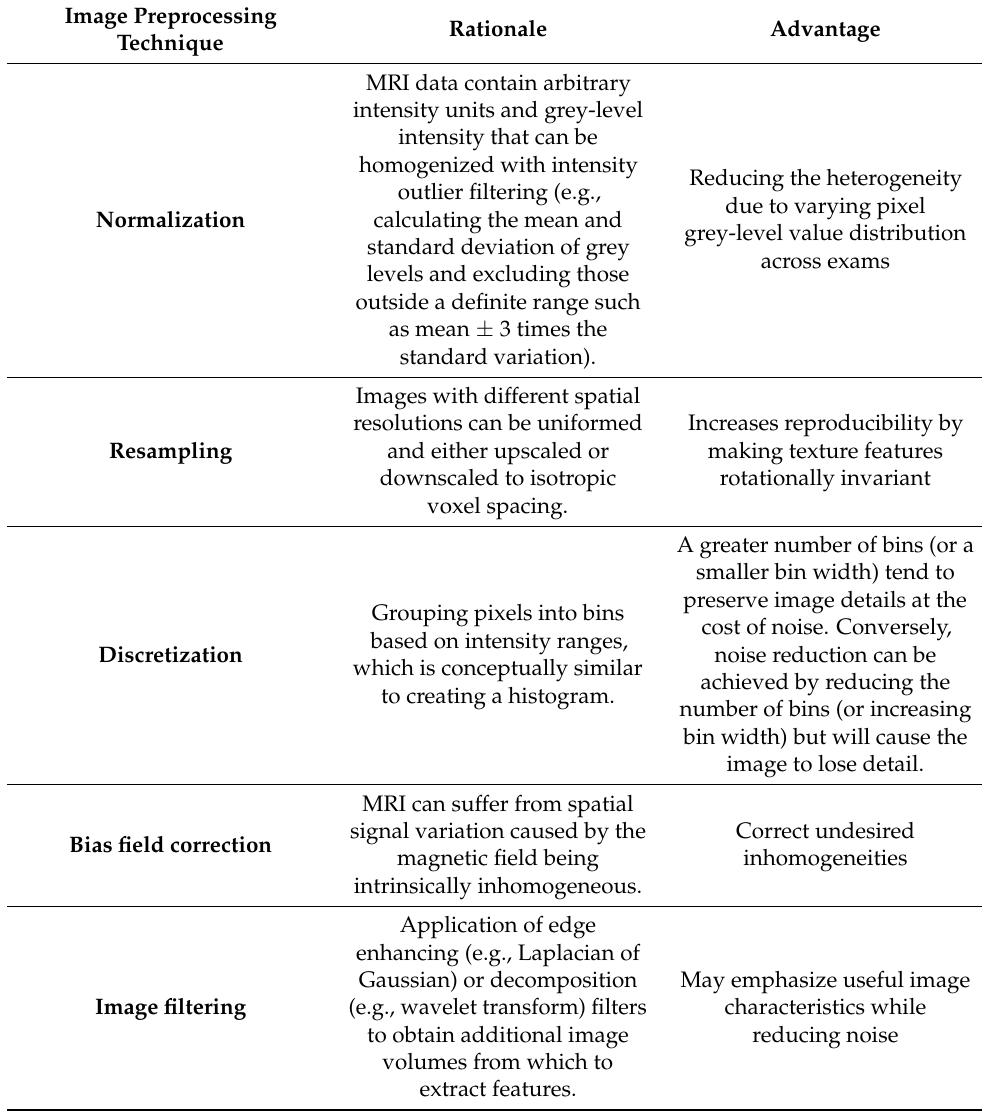
Table 1. Image preprocessing techniques are presented, with their rationale and